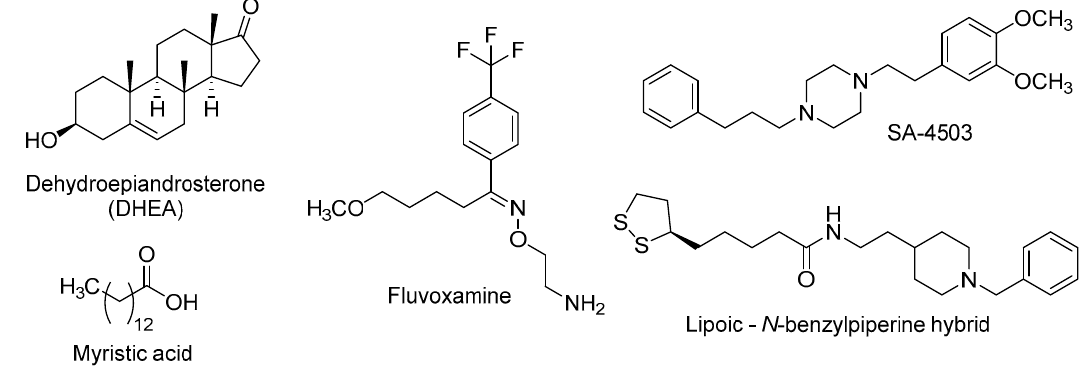
Figure 4. Some σ 1 R agonists with neurogenic properties.